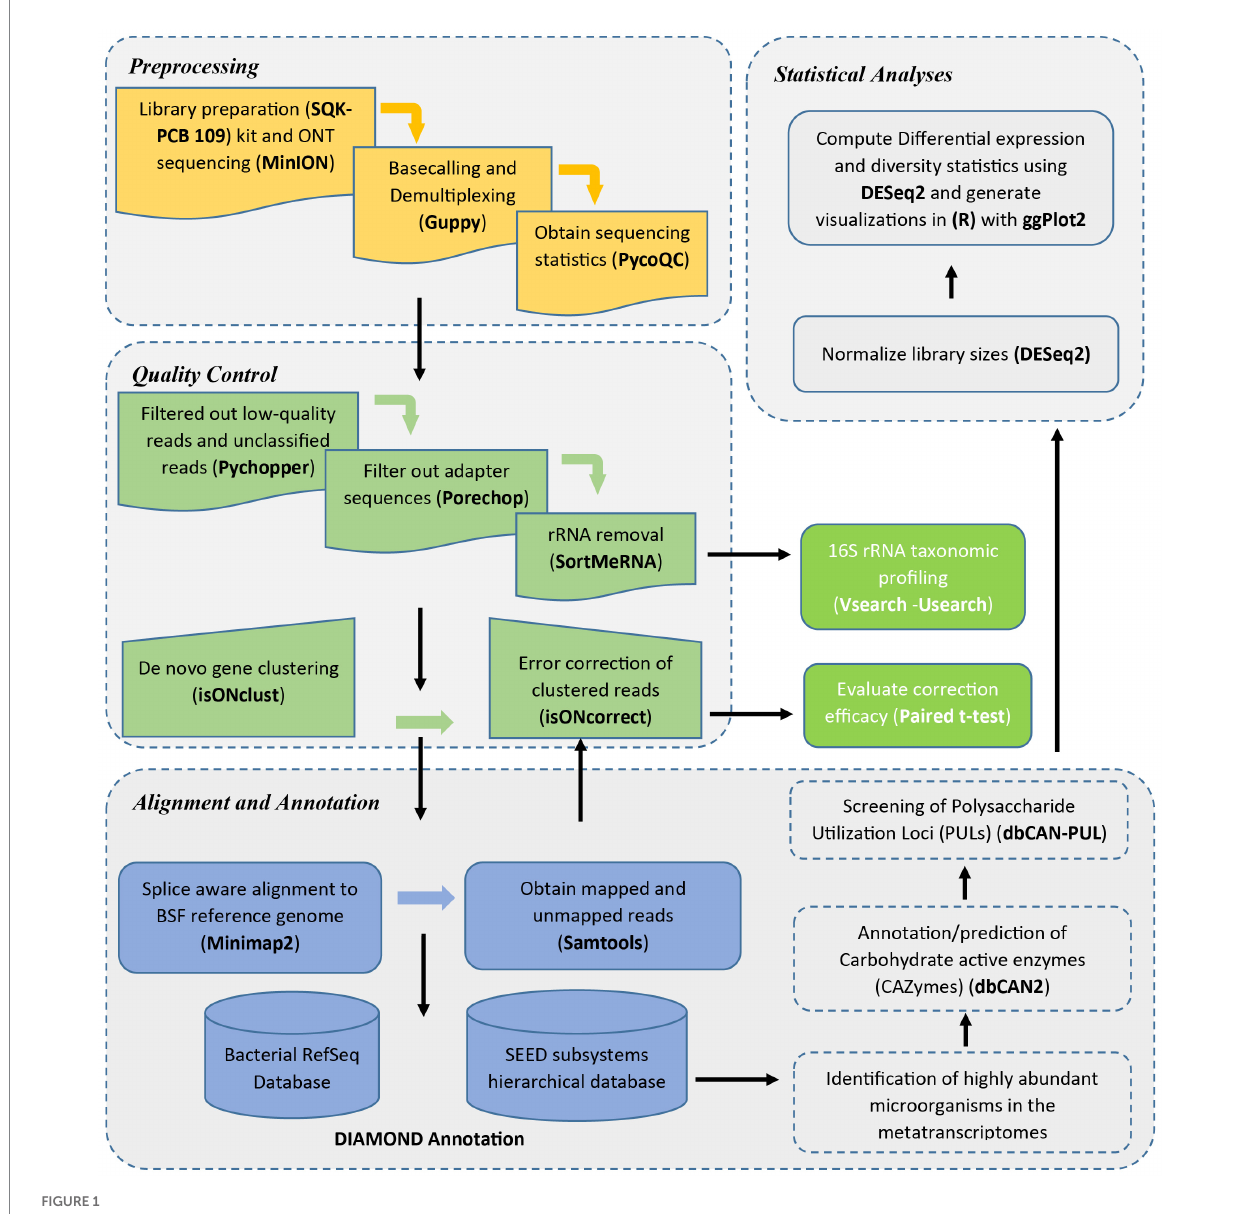
FIGURE 1 Metatranscriptomics analysis